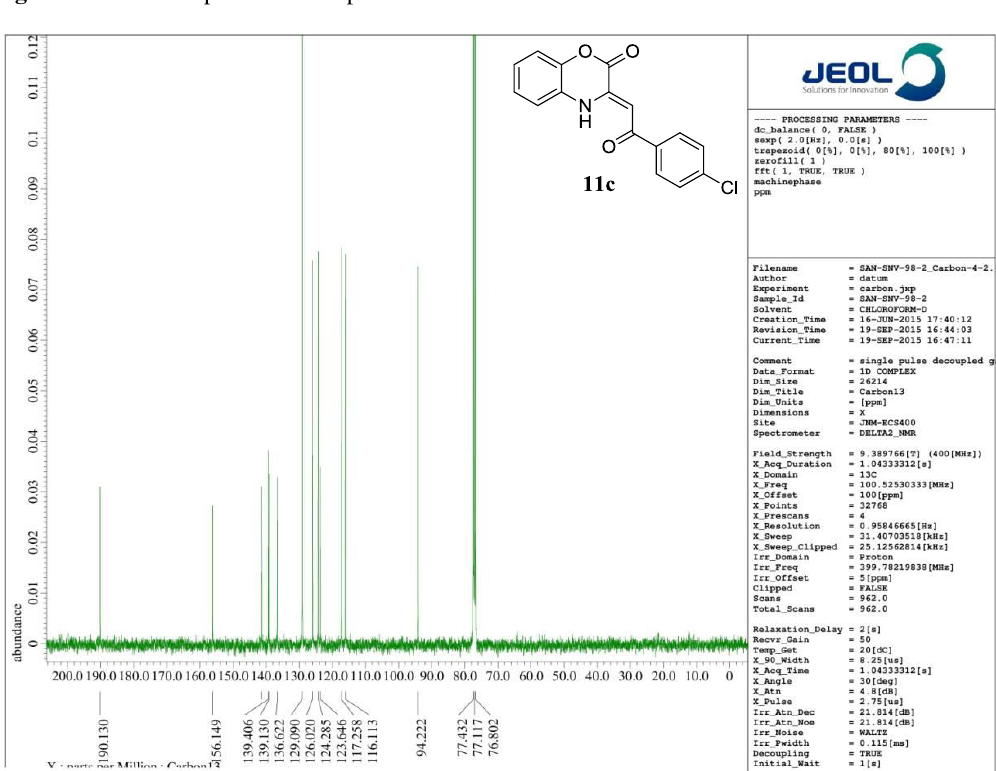
Figure 6. 13 C NMR Spectra of Compound 11c